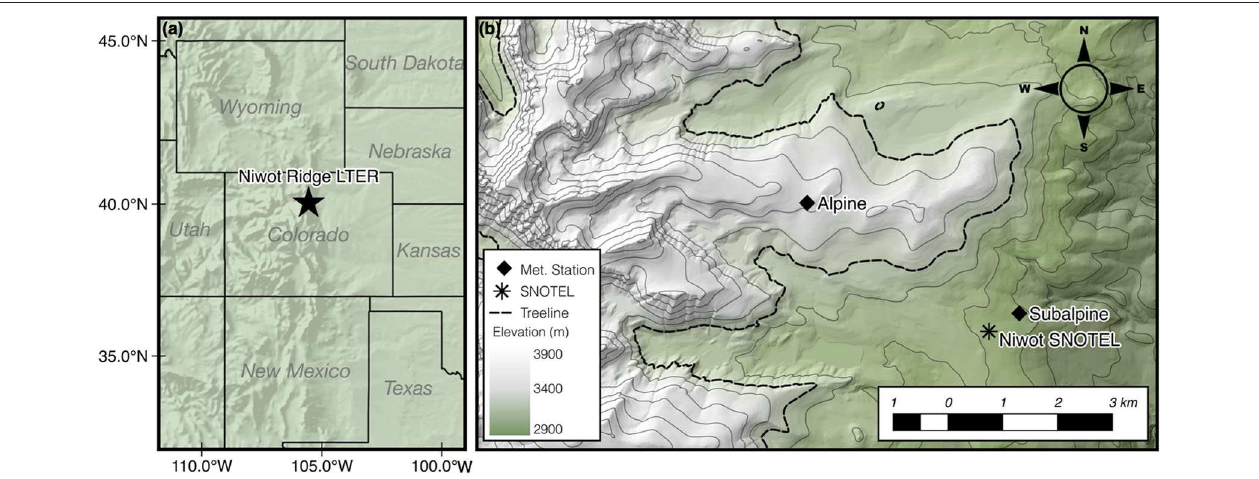
FIGURE 1 | The location of the Niwot Ridge LTER within the western United States (A) and a topographical map showing the co-located meteorological stations and snow pit sites as well as the Niwot Snowpack Telemetry (SNOTEL) station. The dashed line in the LTER inset (B) represents approximate treeline (3,400m a.s.l.) and the thin, solid lines are 100 m contours.